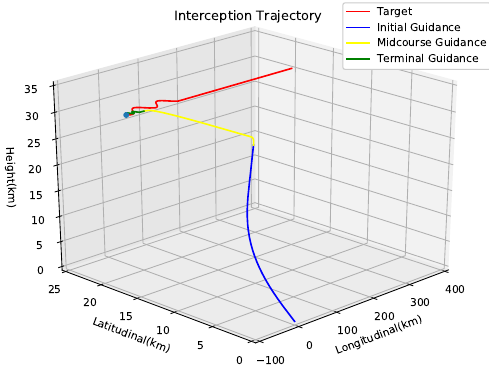
Figure 8. Interception trajectory (target maneuvering).